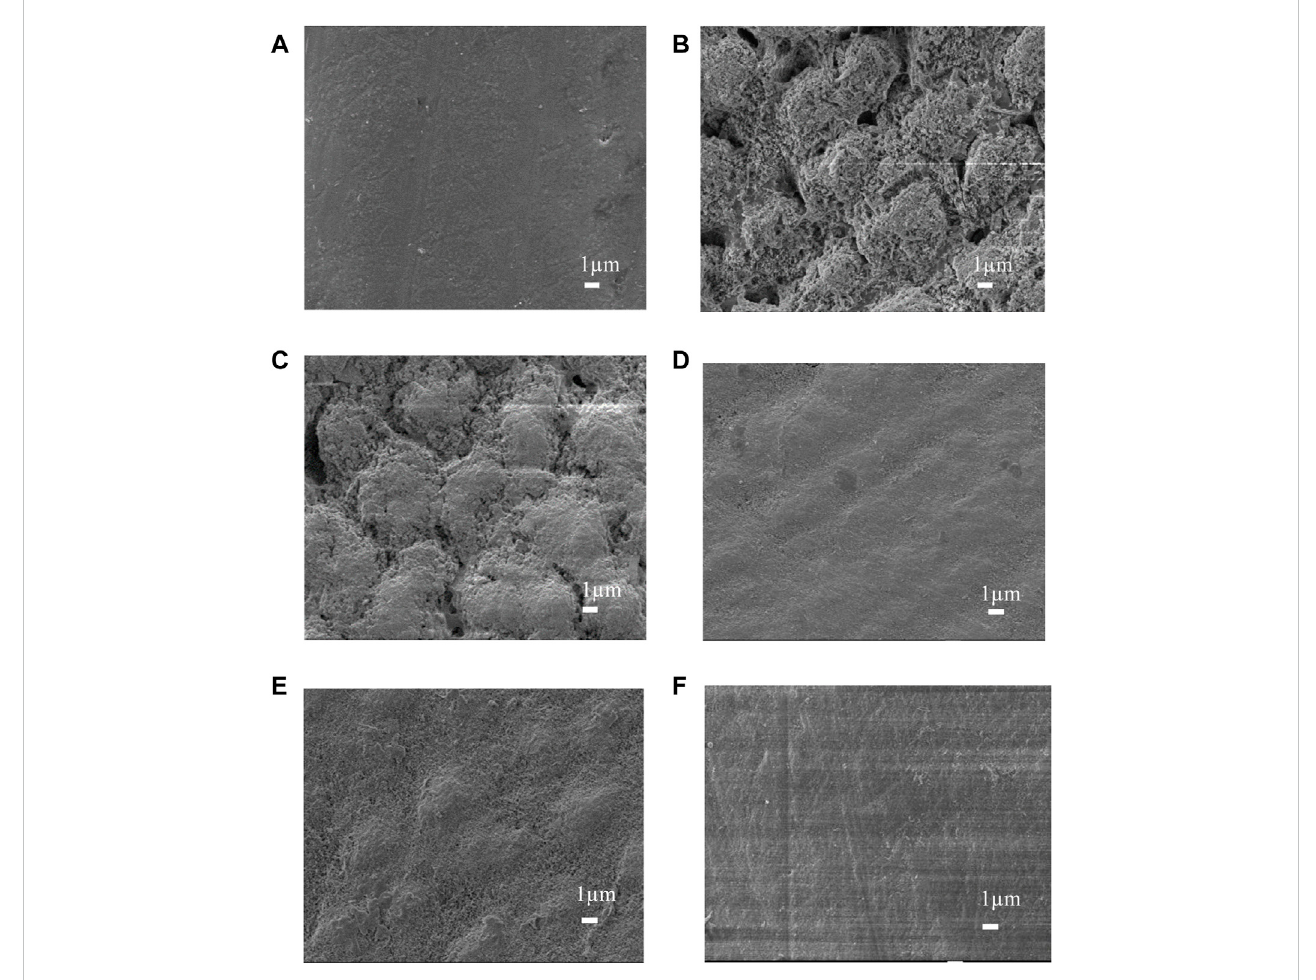
FIGURE 8 SEM images of the enamel surfaces of the four treatment groups. Images before demineralization (A) . Images after arti fi cial demineralization (B) . Images of the nc group (C) . Images of the mbg (D) , cpp-acp (E) and paa-acp@ambg (F) groups.